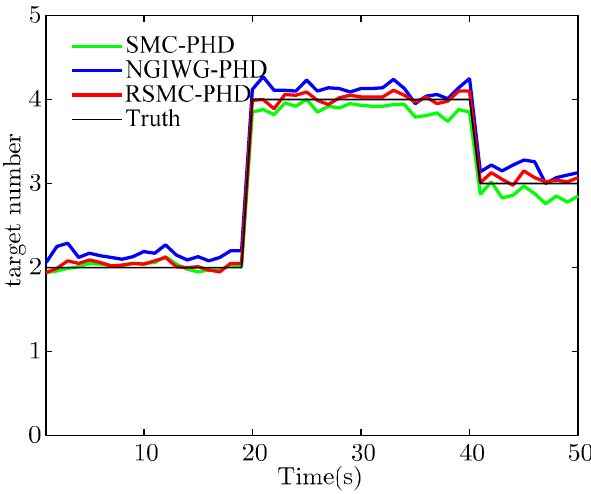
Figure 2. Trajectories of the targets.